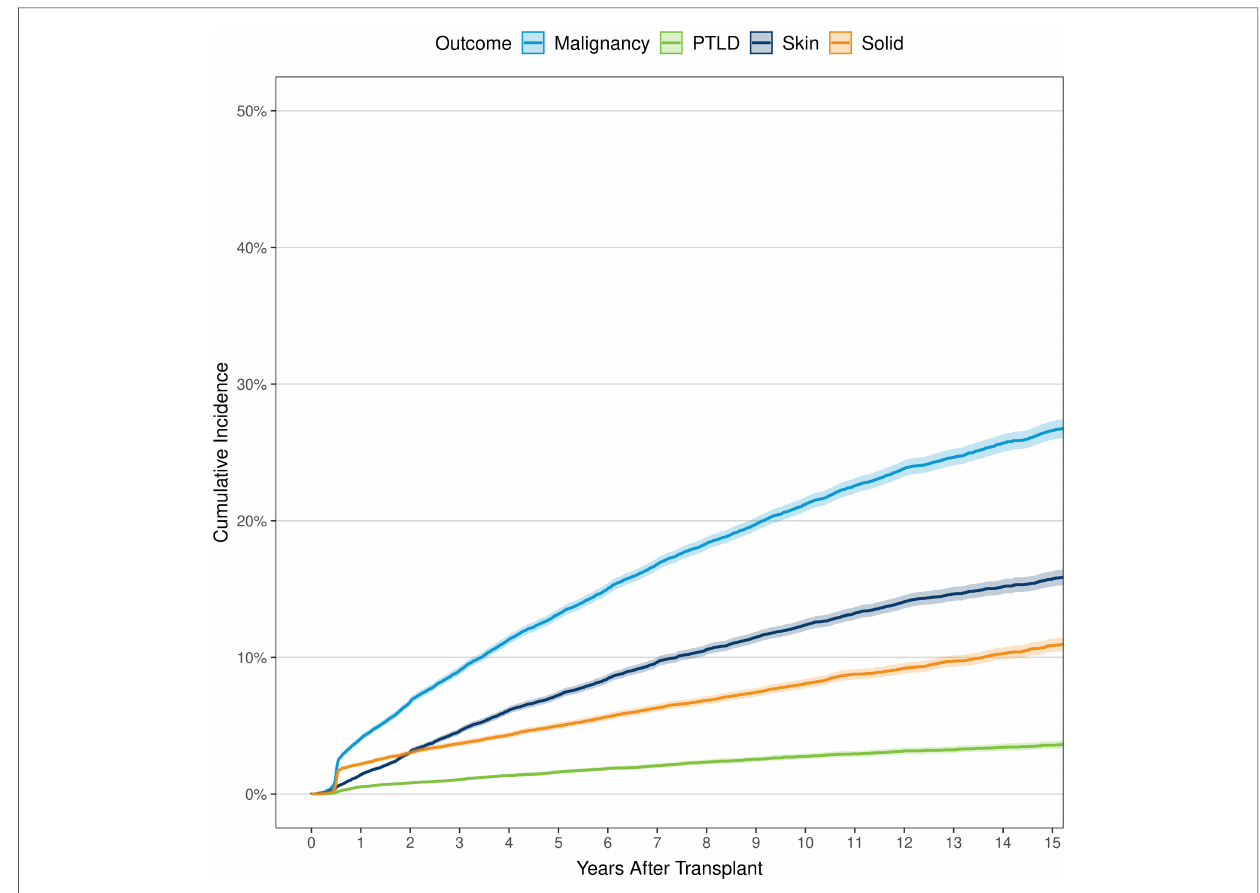
FIGURE 1 Cumulative incidence of any malignancy, solid cancer, post-transplant lymphoproliferative disease, and skin cancer for recipients of primary, orthotopic heart transplants between January 1, 2000 and June 30, 2017 in North America. PTLD, post-transplant lymphoproliferative